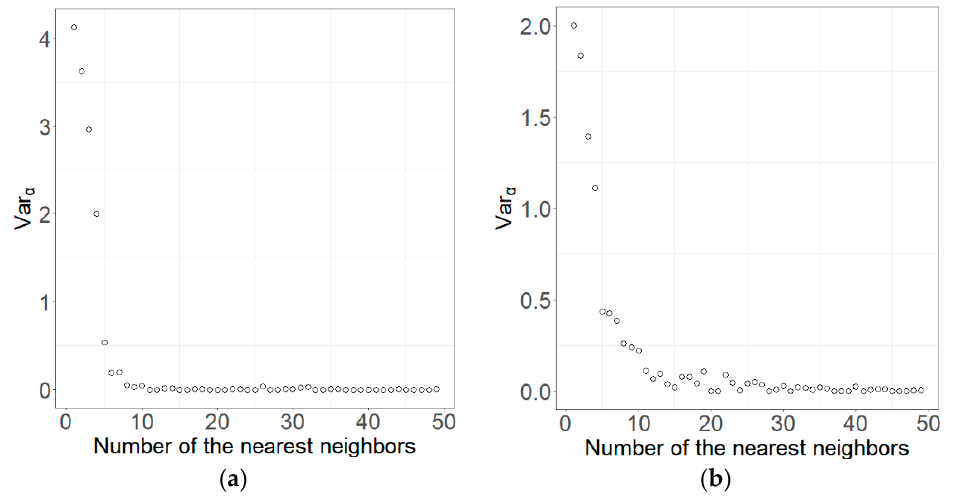
Figure 5. Variance change rates ( Var α ) against k (the number of nearest plots used) for two randomly selected locations (pixels ( a ) and ( b )) to be estimated in Kangbao County.